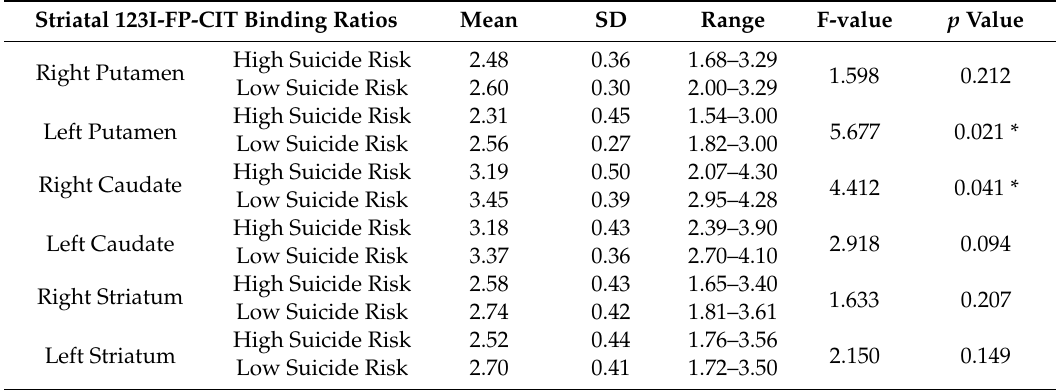
Table 3. DAT striatal availability in High suicide Risk ( n = 20) vs. Low suicide Risk subjects ( n = 31) (ANOVA).